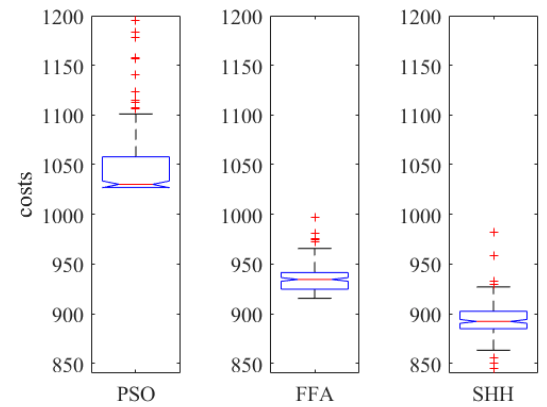
Figure 12. Comparison of the stability of the ultimate total cost value of PSO, FFA and SHH algorithms.